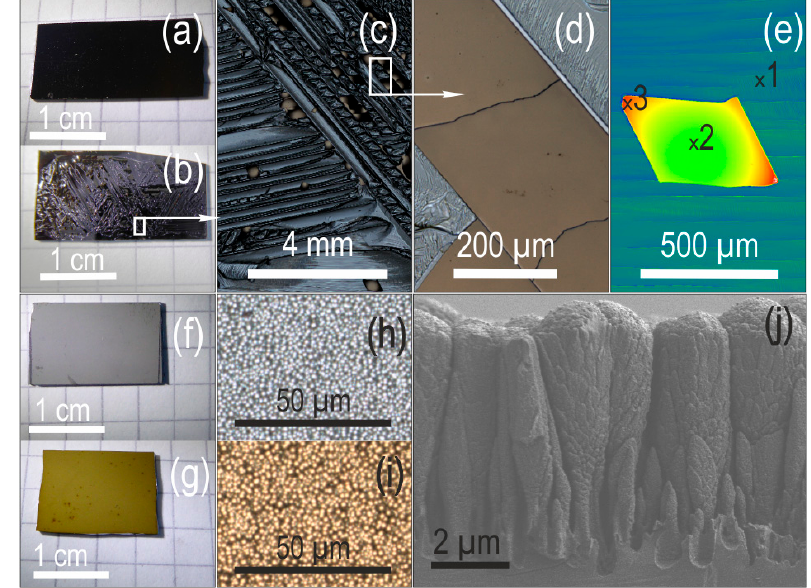
Figure 4. Comparison of RTA test samples before and after treatment at 450 °C. ( a – e ) flat silicon chip; ( a ) before treatment; ( b ) after treatment; ( c ) LSM image of the surface after treatment; ( d ) LSM image of a transformed area; ( e ) height map of an adhered flake. Height level at point 1 = 0 µm, point 2 = 28 µm, point 3 = 50 µm. ( f – j ) chips with black silicon; ( f ) chip with 1 µm RML before treatment; ( g ) after treatment; ( h ) LSM image of the chip surface, 5 µm RML before and ( i ) after treatment; ( j ) cross-sectional SEM image of the transformed RML with 5 µm thickness.